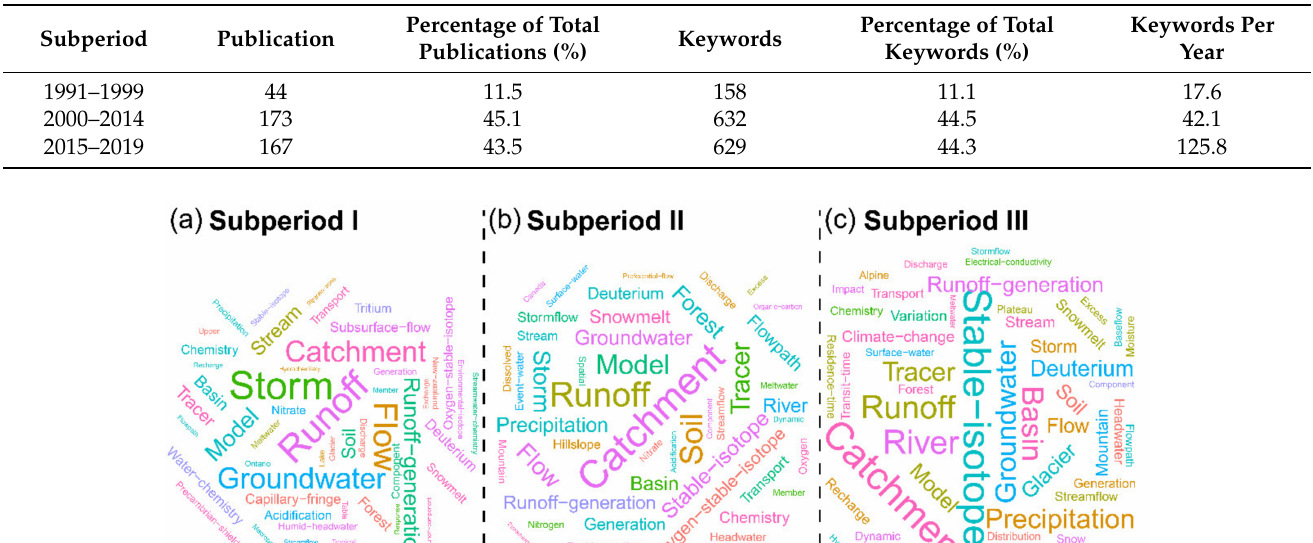
Table 4. Principal information in each subperiod.